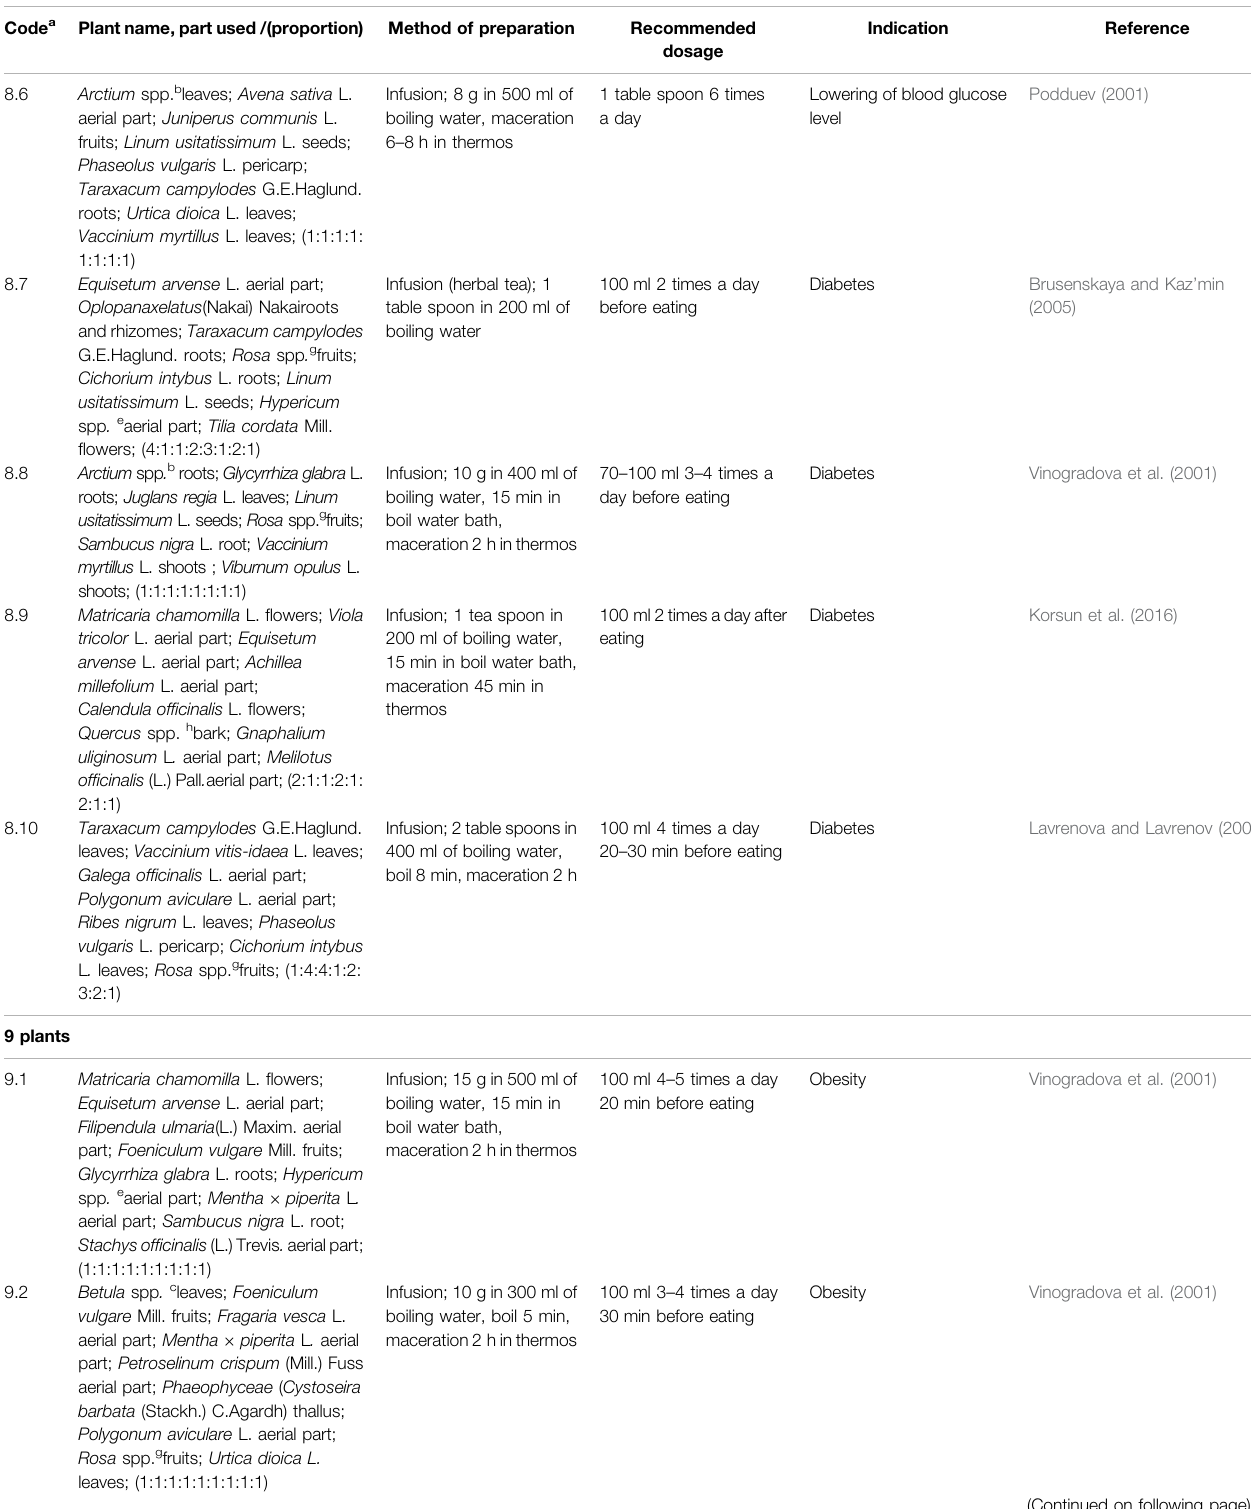
TABLE 1 | ( Continued ) The list of medical species used for the management of diabetes and related disorders in Russia. Code a Plant name, part used /(proportion) Method of preparation Recommended